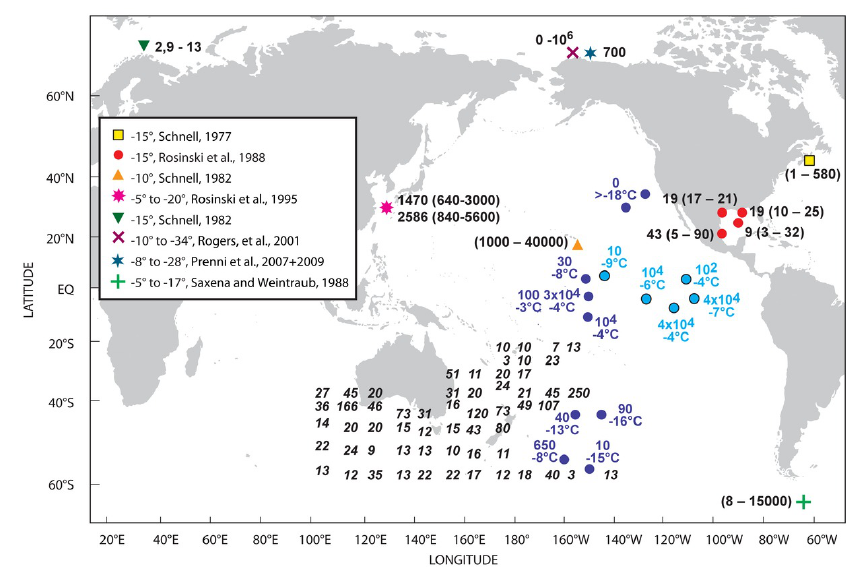
Fig. 1. Number densities of atmospheric ice nuclei (m − 3 ) in the marine boundary layer. Measurements by condensation-followed-by-freezing, ship-based and coastal : Australia (italic text): − 15 ◦ C and water saturation (Bigg, 1973). Pacific Ocean: 29 May–16 June 1985: Rosinski et al. (1987). 17 February–29 March 1984: Rosinski et al. (1987). Gulf of Mexico: Rosinski et al. (1988). East China Sea: Rosinski et al. (1995). Arctic: Bigg (1996). Antarctica: Saxena (1983). Nova Scotia: Schnell (1977). Airborne measurements by drop freezing: Hawaii: Schnell (1982). Airborne measurements by continuous flow diffusion chamber: Arctic: Rogers et al. (2001); Prenni et al.